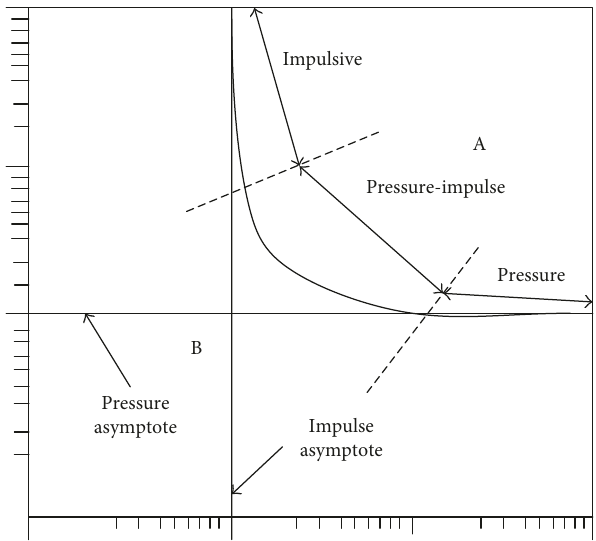
Figure 6: Typical P - I curve